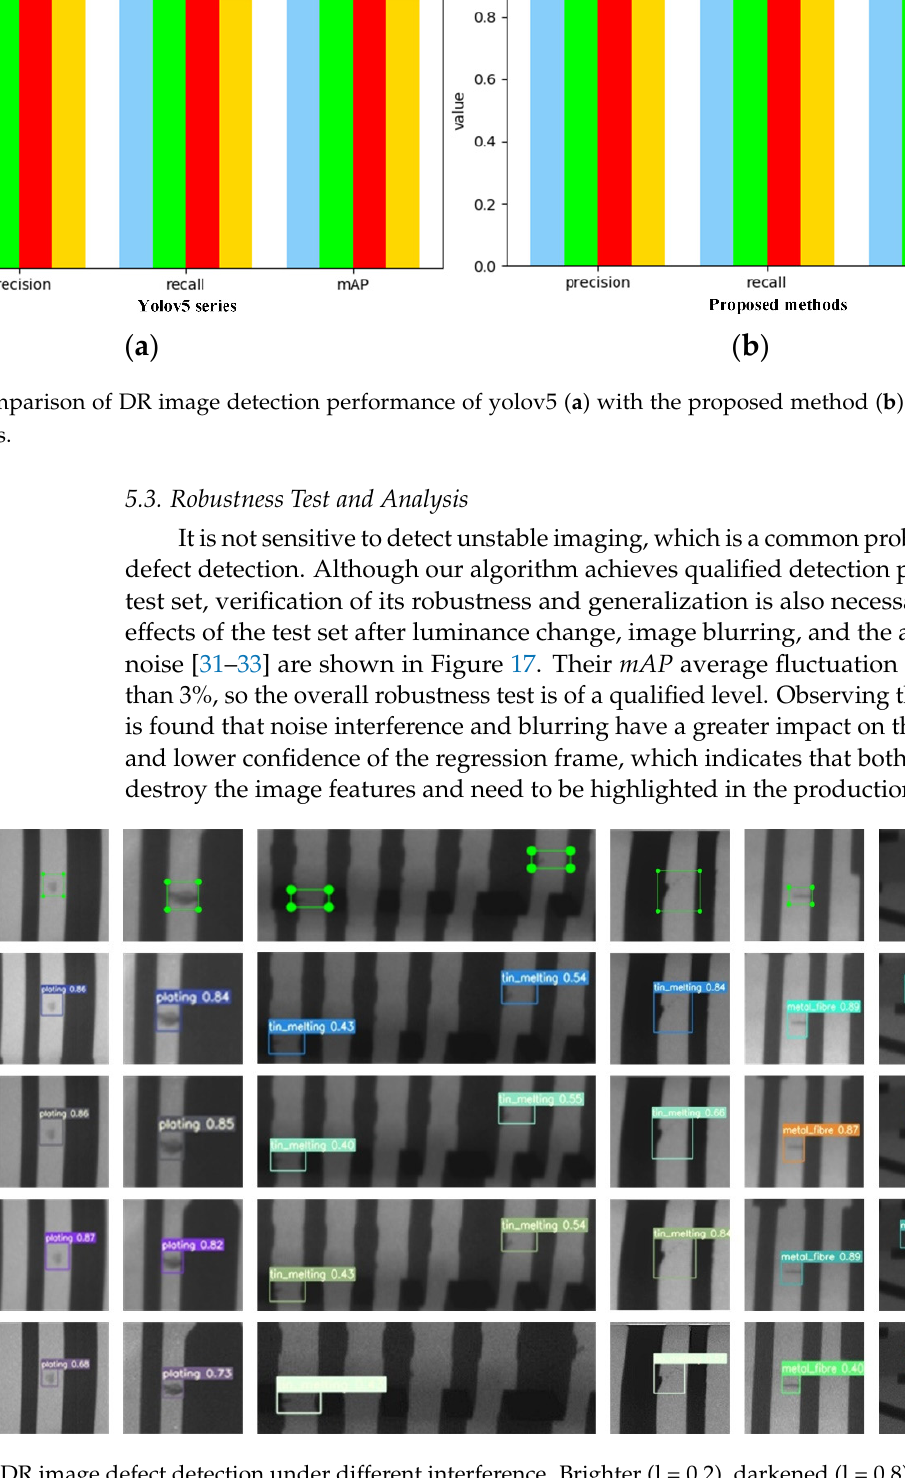
Figure 18. Confusion matrix results for detection. ( a ) Confusion matrix of detection results for yolov5s. ( b ) Confusion matrix of detection results for yolov5s6. ( c ) Confusion matrix of detection results for our proposed method. It can be seen that the majority of detection errors tend to focus on false positives, where background interference is misclassified as a defect, along with samples that are detected but misclassified, while the proportion of true negatives is small in comparison. Combined with some inspection examples, as shown in Figure 19, it is difficult to be sure of the authenticity of the defect manually in the local field of view, while extending the field of view will further determine whether it is a defect or interference. Therefore, we reasoned that having prior knowledge and a larger receptive field will help to exclude such interference, which will be explored in further study.